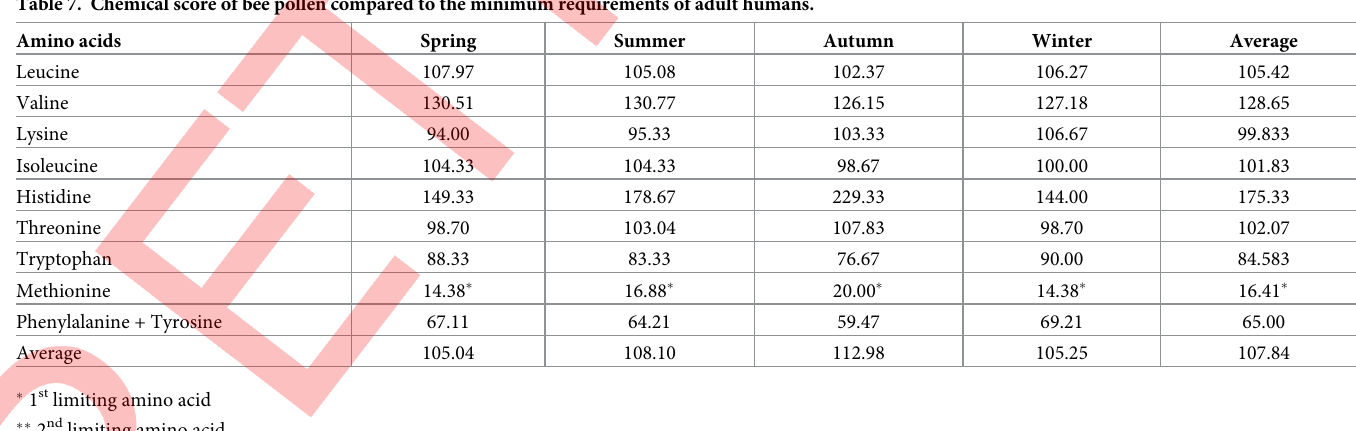
Table 7. Chemical score of bee pollen compared to the minimum requirements of adult humans. Amino acids